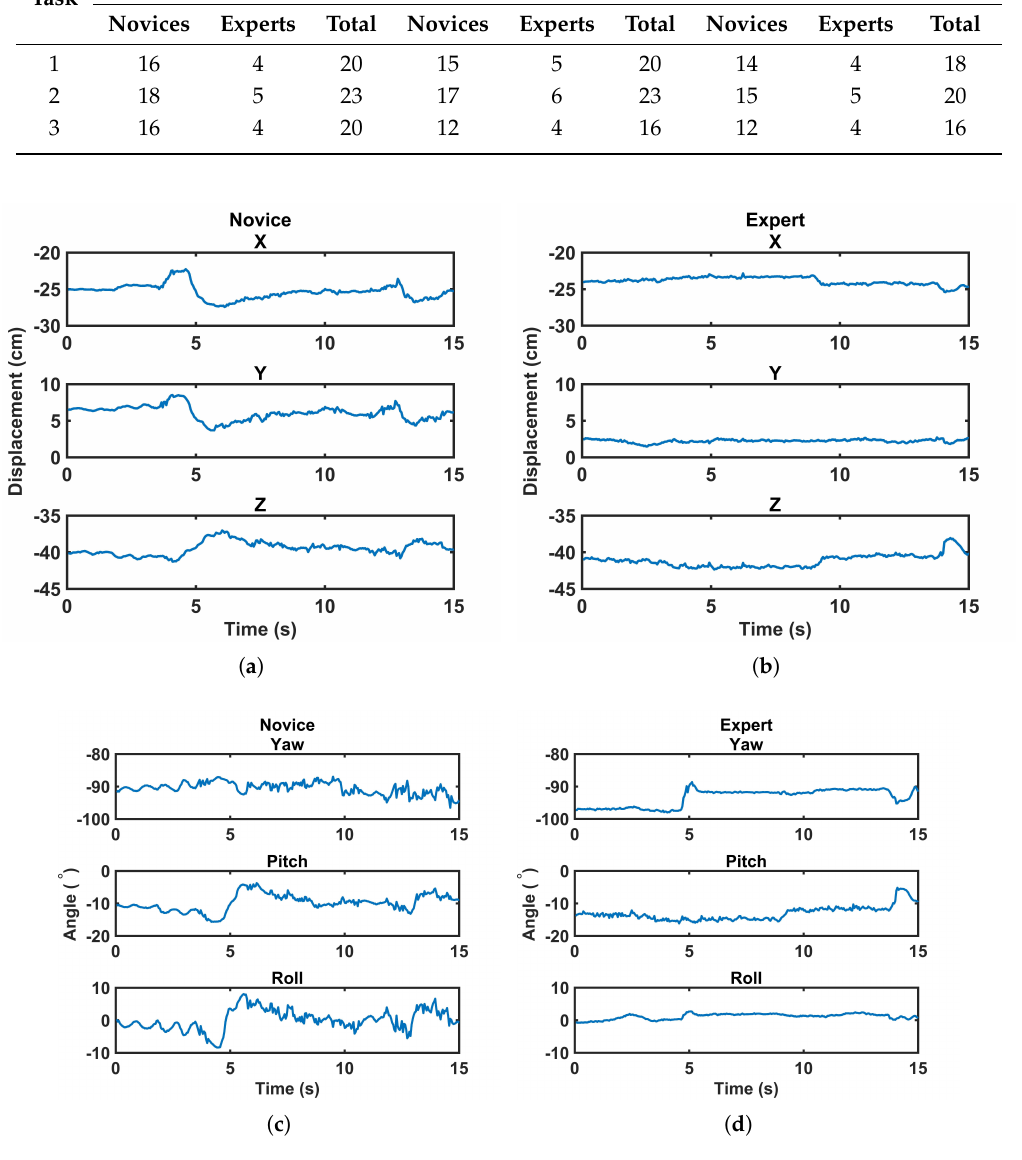
Figure 3. The arthroscope’s tip displacement ( a , b ), and angle ( c , d ) for a random novice and expert subject over the same time